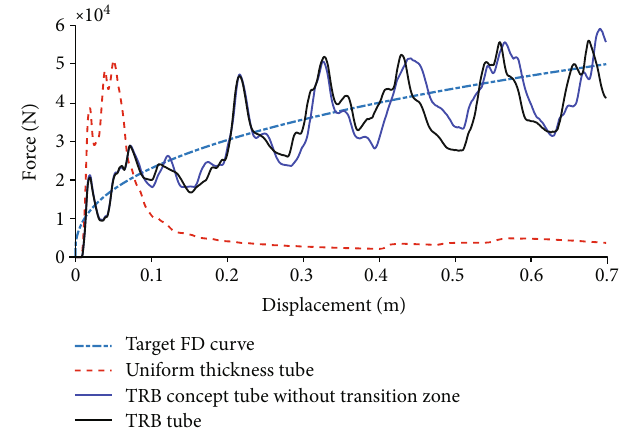
Figure 30: The FD curve of the uniform thickness tube and designed tube.